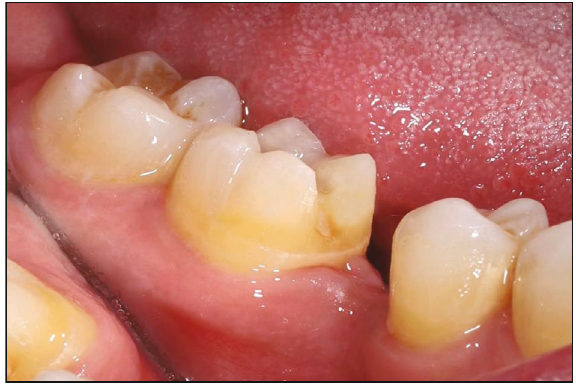
Figure 7: Evaluation of resin-bonded inlay-retained cantilever fi xed dental prosthesis before cementation.